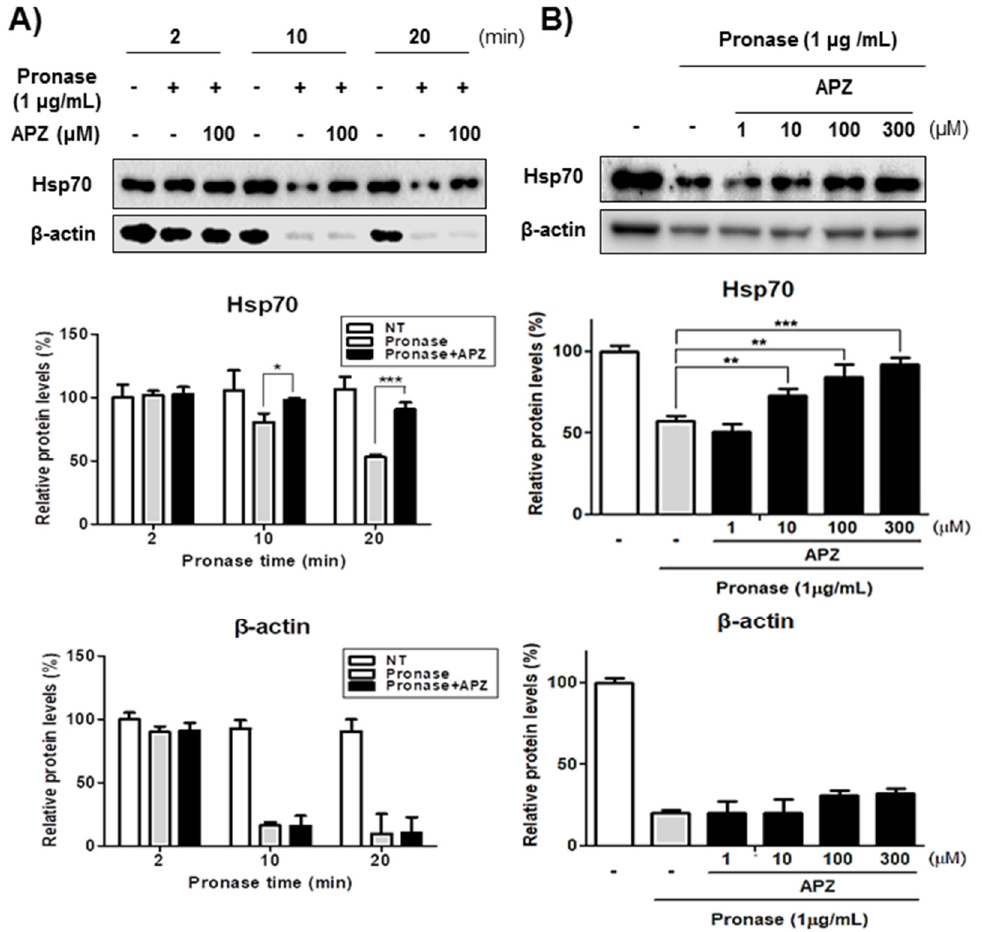
Figure 5. Characterization of Hsp70 as a potential target of APZ. ( A ) DARTS assay for target validation. Hsp70 and β -actin protein stability were unaltered upon APZ treatment in HeLa cell lysates. Pronase treatment was conducted for 2, 10, and 20 min. The graph plots the quantification data shown in b. n = 3, * p < 0.05, *** p < 0.001. ( B ) The DARTS assay demonstrated a dose-dependent binding of APZ to Hsp70. Treatment with 1 µ g / mL pronase was conducted for 20 min. The graph plots the quantification data shown in b. n = 3, ** p < 0.01, *** p < 0.001. More details of western blot, please view at the supplementary materials.